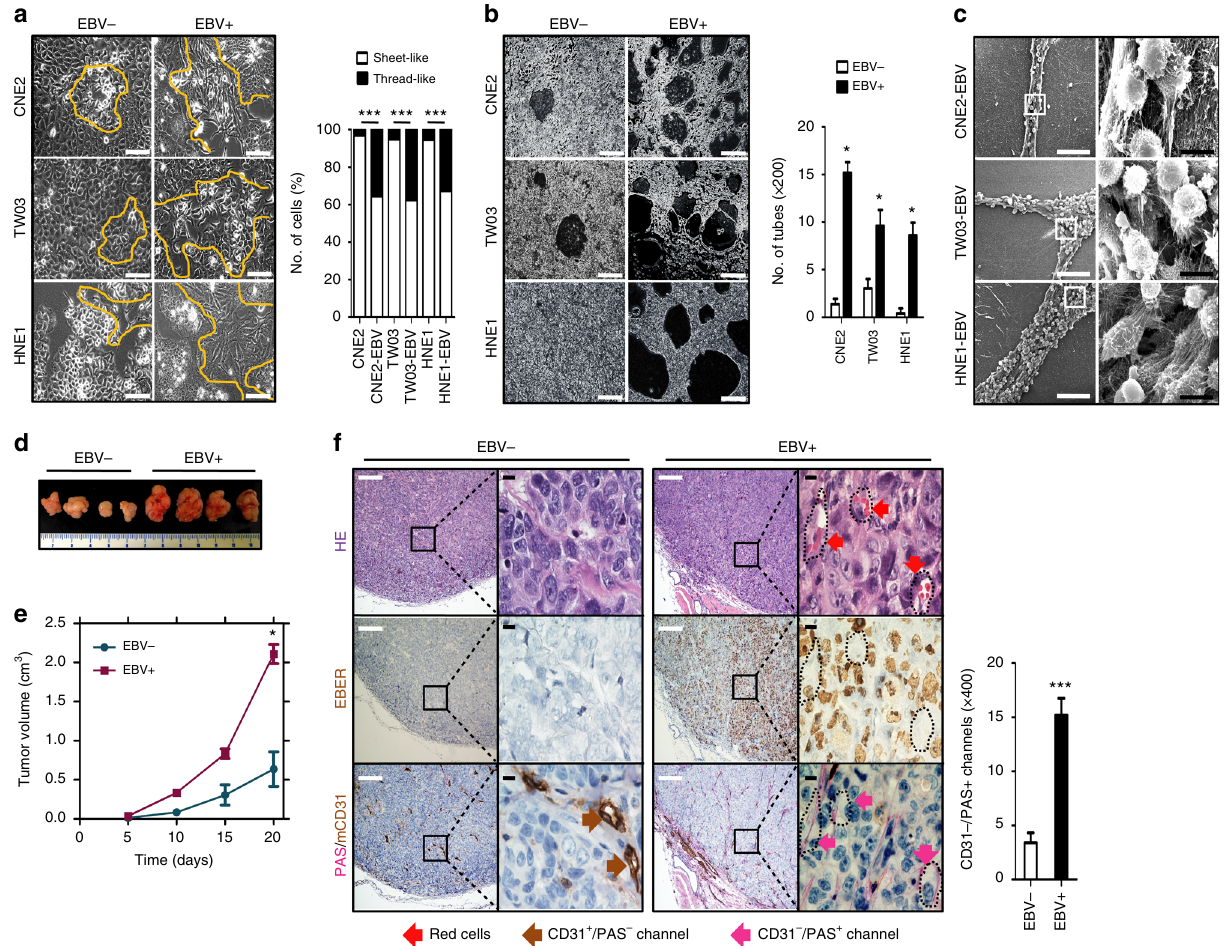
Fig. 1 EBV infection promotes VM formation in vitro and in vivo. a (Left) Morphologies of EBV-infected NPC cells and their parental cells grown in conventional 2D culture plates. Cells are mixed with the sheet-like and thread-like cell types, and the latter were outlined with yellow lines. Scale bars = 100 μ m. (Right) Quanti fi cation of the sheet-like and thread-like cell types in EBV-infected NPC cells and their parental cells. More than 100 cells were counted in randomly chosen fi elds. Mean± SD, n = 5, *** p < 0.001 (two-tailed unpaired t -test). b Images (left) and quanti fi cation (right) of tube formation in EBV-infected NPC cells and their parental cells. Images were taken 12 h after seeding on Matrigel. Scale bars = 100 μ m. Tubes were counted under a microscope with 200× magni fi cation in randomly chosen fi elds. Mean± SD, n = 5, * p < 0.05 (two-tailed Mann – Whitney test). c EBV-infected NPC cells displayed tubular networks and channels in 3D Matrigel, as observed by scanning electron microscopy. Scale bars = 100 μ m (left panel), scale bars = 10 μ m (right locally enlarged images). d CNE2 and CNE2-EBV cells were subcutaneously injected into nude mice, and images were taken 20 days post- implantation. e Growth curves of xenograft tumors formed by CNE2 and CNE2-EBV cells. Mean± SD, n = 4, two-tailed Mann – Whitney test. f The presence of VM in CNE2-EBV xenografts but not in control CNE2 xenografts. Pink arrows indicate VM channels (PAS + /mCD31 − ), which are formed by tumor cells (as stained by EBER) and containing red blood cells (stained by H&E; red arrows); brown arrows indicate typical blood vessels with brown mCD31 + staining. White scale bars = 100 μ m, black scale bars = 10 μ m. (Left) Quanti fi cation of PAS + /mCD31 − channels determined by microscopy with 400× magni fi cation in randomly chosen fi elds. Mean ± SD, n = 5, *** p = 0.0002 (two-tailed unpaired t